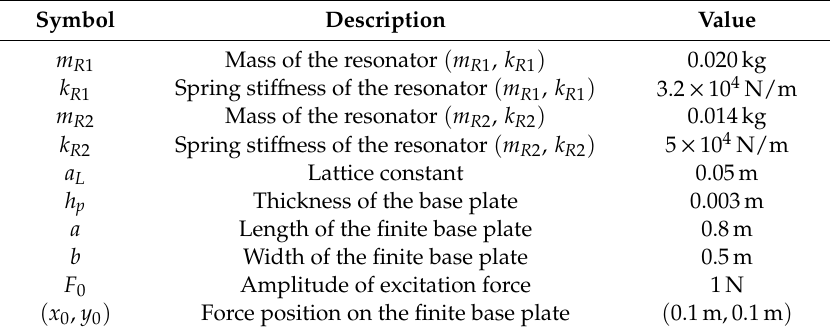
Table 1. Parameters of the periodic element and the details of the base plate in the finite locally resonant plate with two resonators in each periodic element.